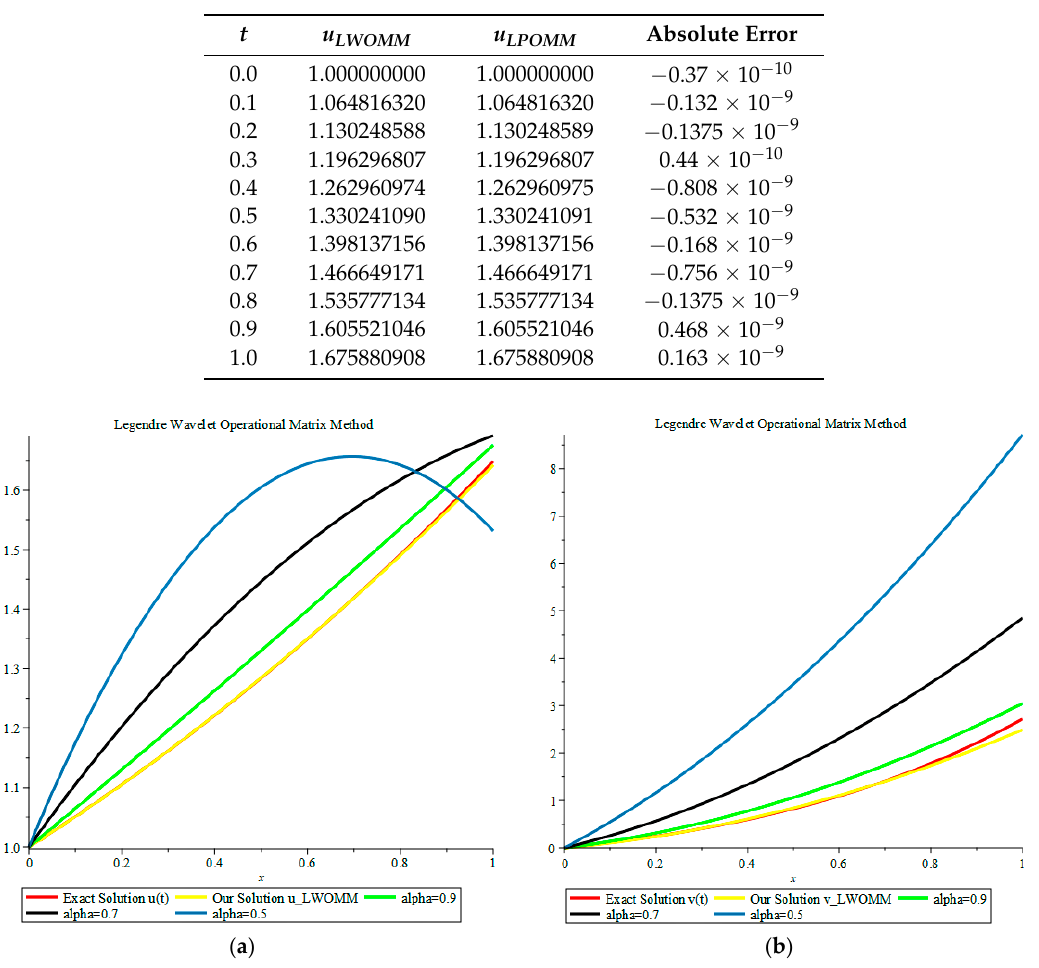
Table 5. Our solutions u ( t ) when α = 0.9 attained by the presented method and the LPOMM for Example 3.